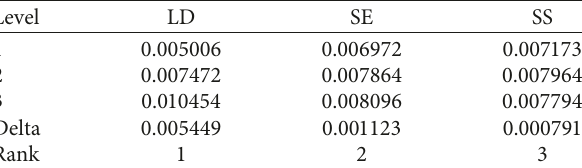
Figure 8: Effects of plot on WR. Table 4: Response output for